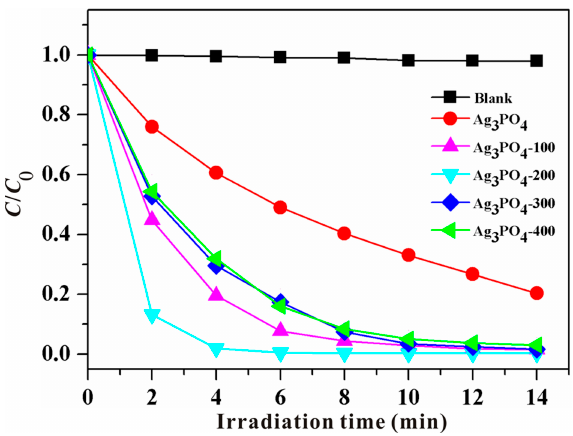
Figure 1. Photocatalytic degradation of MB over pristine Ag 3 PO 4 and Ag 3 PO 4 -T (T = 100, 200, 300 and 400) samples under visible light irradiation.